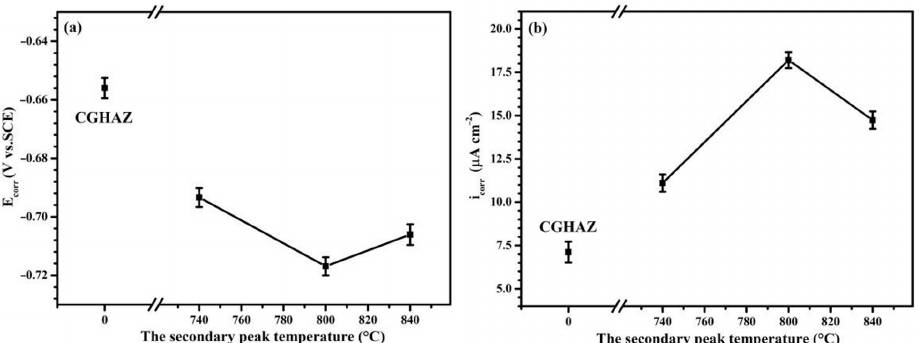
Figure 11. Fitting results of E corr ( a ) and i corr ( b ) for the CGHAZ and ICCGHAZs with different secondary peak temperatures in 3.5 wt% NaCl solution.